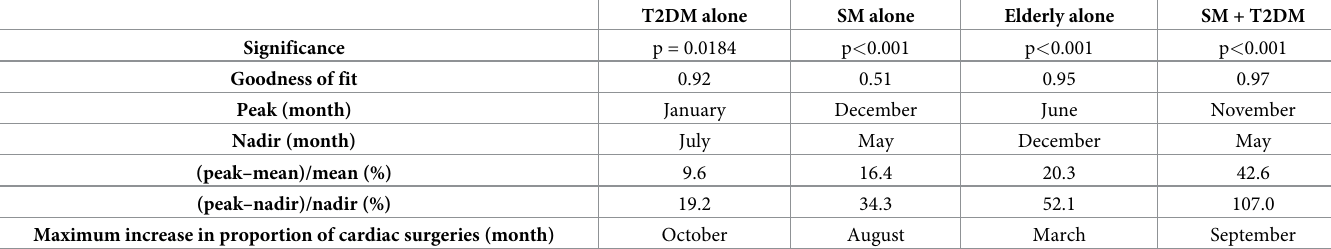
Table 1. Characteristic parameters of seasonality for statistically significant variables.